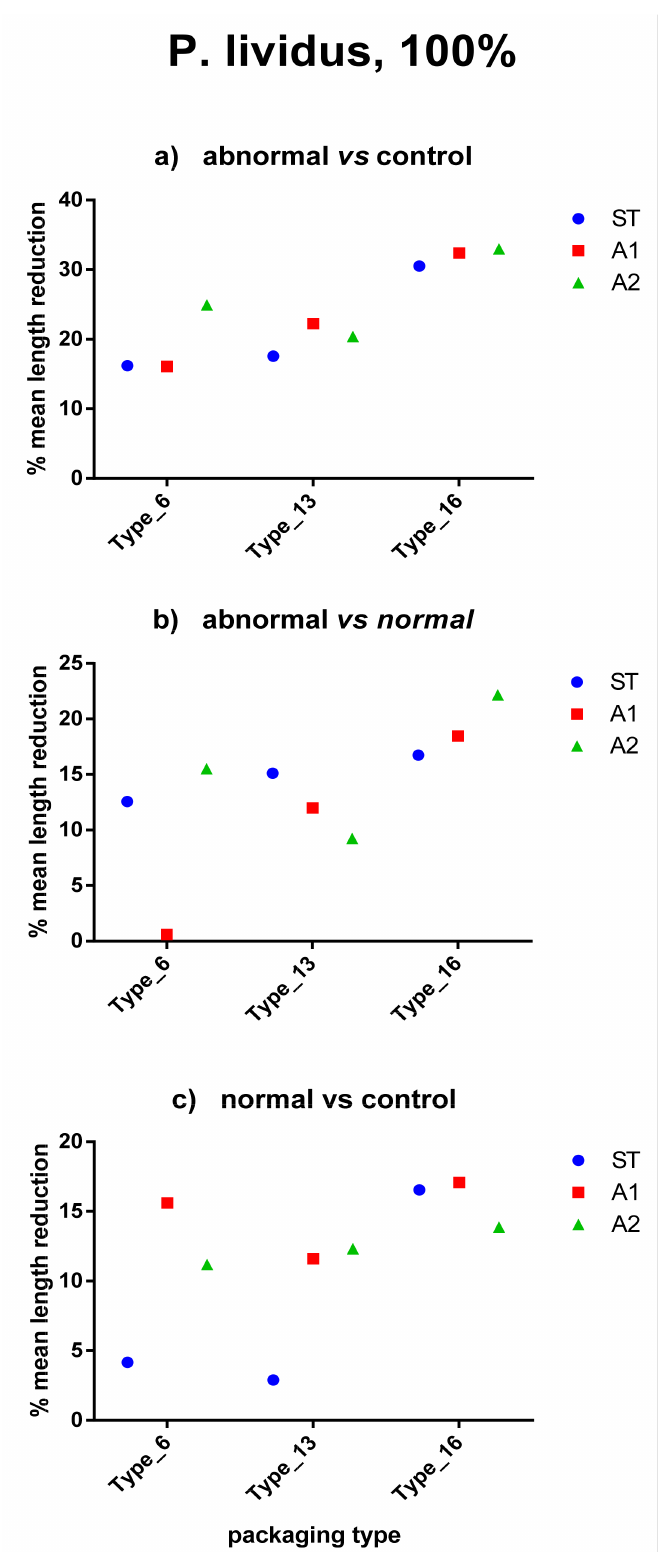
Figure 3. Body-size reduction in P. lividus larvae exposed to different plastic types according to water pH (100% dilution). Mean arms lengths of anomalous larvae are compared respect to ( a ) controls and ( b ) normal larvae. ( c ) shows comparison between normal-developed larvae and controls. In all cases, Type_16 (i.e., PET) induced more evident